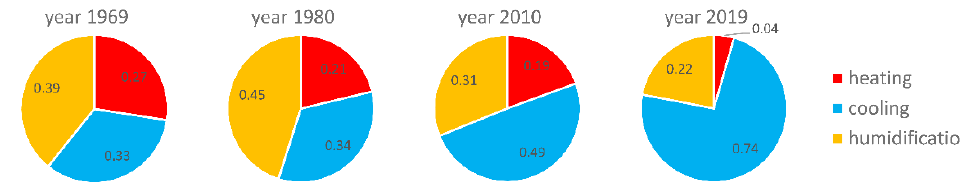
Figure 12. Share of energy for air treatment steps in total energy demand, t sup 1 = 15 °C.